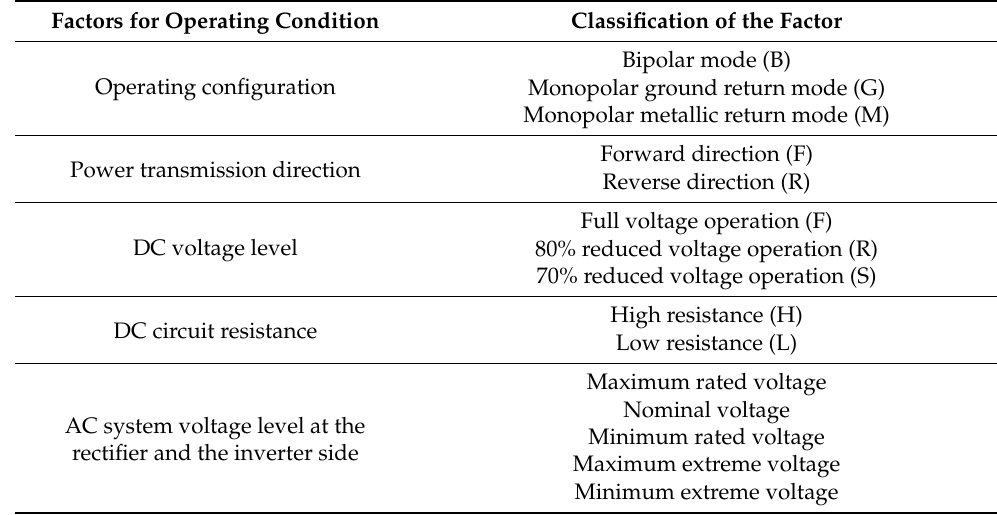
Table 1. Summary of technical characteristics of various